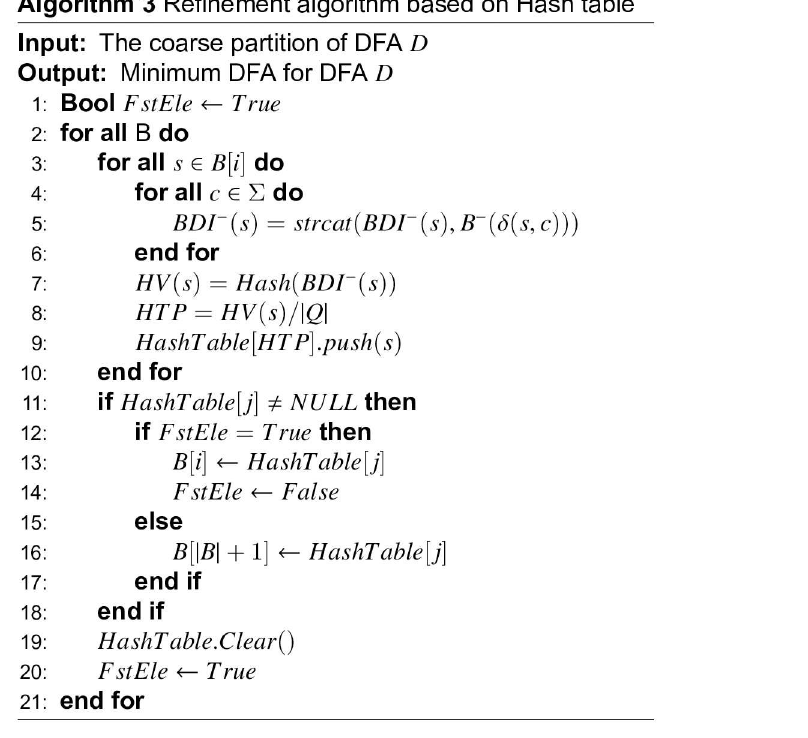
Fig 6. Refinement algorithm based on hash table.